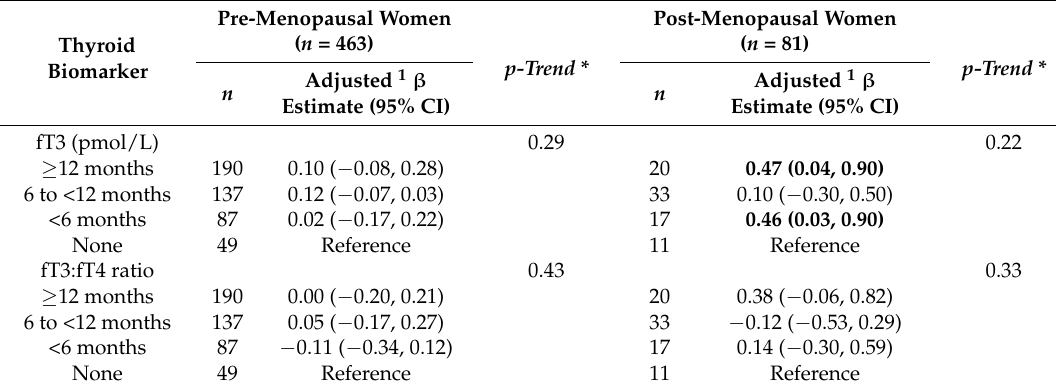
Table A2. Associations between lactation duration and fT3 and the fT3:fT4 ratio by menopausal status among women with a history of gestational diabetes, Diabetes & Women’s Health